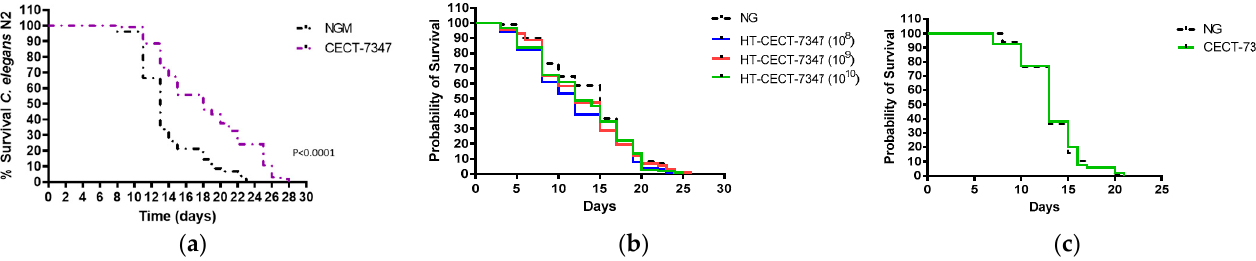
Figure 3. Effect of the strain CECT-7347 and HT-CECT-73 47 on C. elegans lifespan. ( a ) B. longum CECT-7347 significantly increases lifespan of C. elegans wild-type strain (N2) ( b ) Cells of HT-CECT-7347 do not increase C. elegans (N2) lifespan (dose 10 8 , 10 9 , and 10 10 cells/plate) ( c ) Lifespan increase by B. longum CECT-7347 is lost in the C. elegans in DAF-16 (GR1307) mutant strain. Curve comparisons vs. E. coli OP50 are indicated ( p -values). Log Rank T-test was applied. Data correspond to the average of two independent assays ( n = 200/condition).